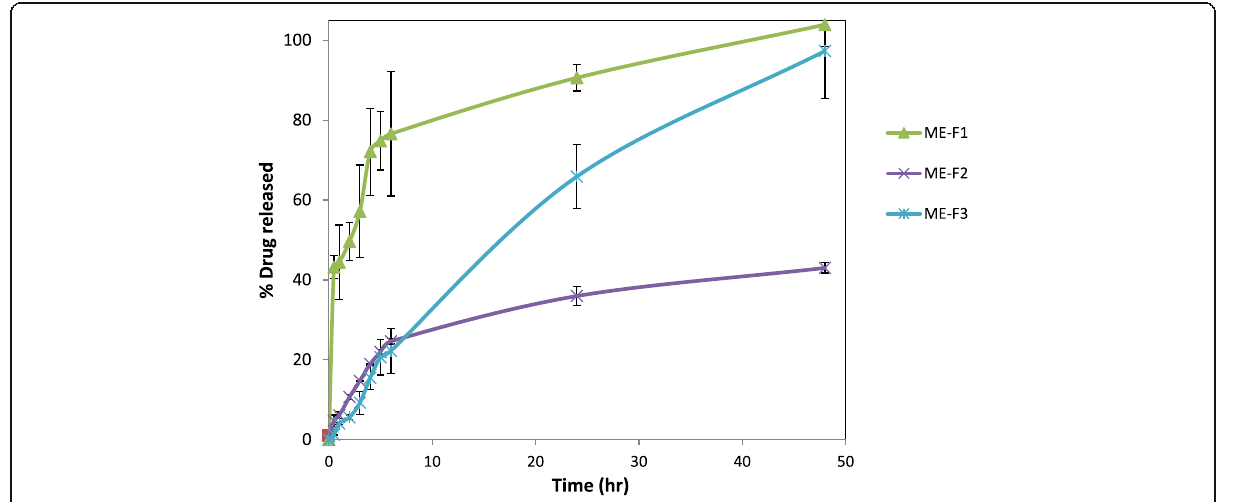
Fig. 2 Different extracts release from the formulated MEs